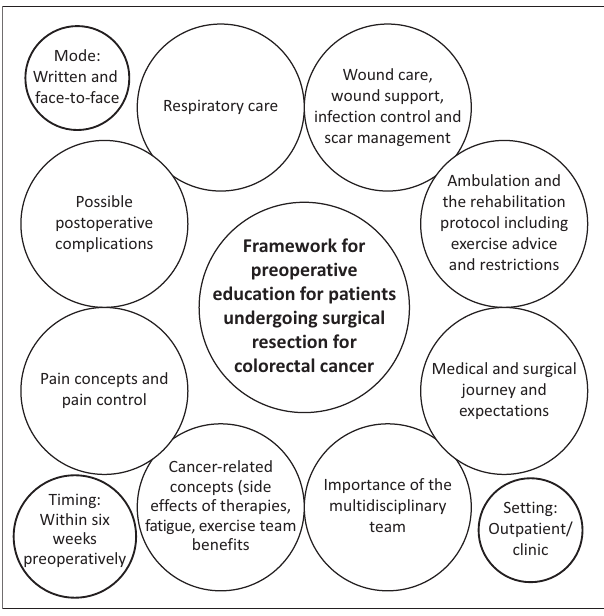
FIGURE 3: Framework for preoperative education for patients undergoing surgical resection for colorectal